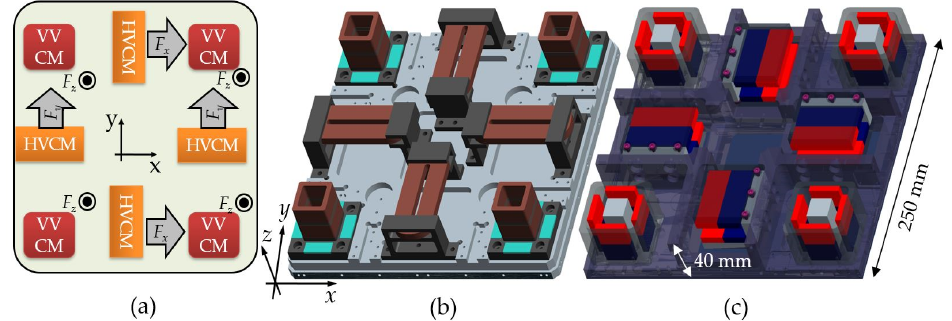
Figure 2. Design of the fine stage: ( a ) The topology of the VCMs; ( b ) the fine stage stator with coils; and ( c ) the fine stage mover with magnets (inverted) [27]. Reprinted from International Journal of Applied Electromagnetics and Mechanics, 62, Dahoon Ahn, et al., Design process of square column-shaped voice coil motor design for magnetic levitation stage, 517–540, Copyright (2020), with permission from IOS Press. Table 1. Design specifications of the VCMs of the fine stage [27] Reprinted from International Journal of Applied Electromagnetics and Mechanics, 62, Dahoon Ahn, et. al., Design process of square column-shaped voice coil motor design for magnetic levitation stage, 517–540, Copyright (2020), with permission from IOS Press.